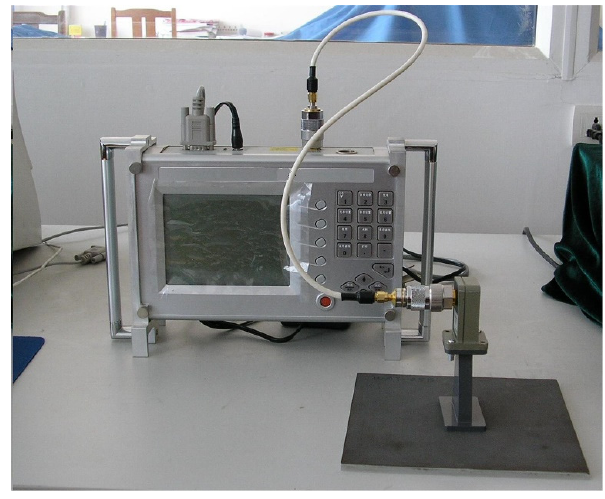
Figure 4. Testing process.